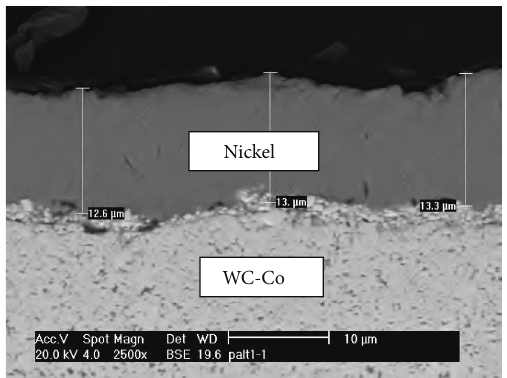
Figure 2: SEM image of electroplated nickel coating on hard metal surface when plating time is 10min and anode/cathode gap distance is 5mm.